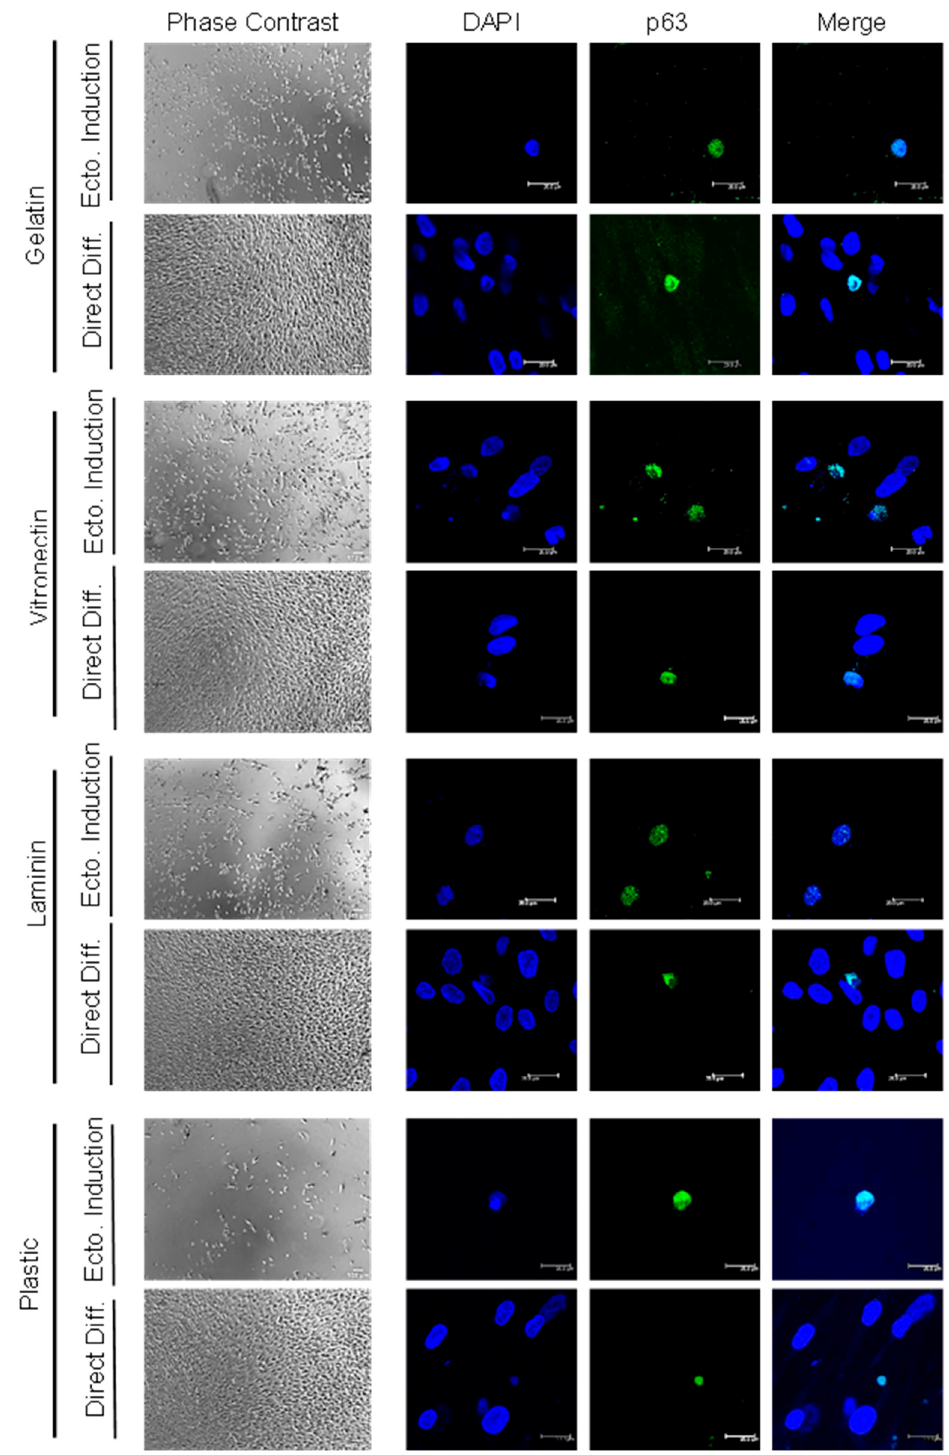
Figure 3. p63 α immunofluorescence of c-Kit-negative hADSC-derived LSCs. Representative phase contrast and confocal microscopy images seeded on various coatings (gelatin, vitronectin, laminin and plastic) after employing 2 different culture methods: differentiation after ectodermal induction (Ecto. Induction) or direct differentiation (Direct Diff.); p63 α in green and nuclei in blue; scale bar 200 μ m (phase contrast) and 20 μ m (confocal images). 2.2. High Differentiation Efficiency of hADSCs into LSCs Is Achieved by Previous Ectodermal Induction and Vitronectin Coating, Independent of c-Kit Expression